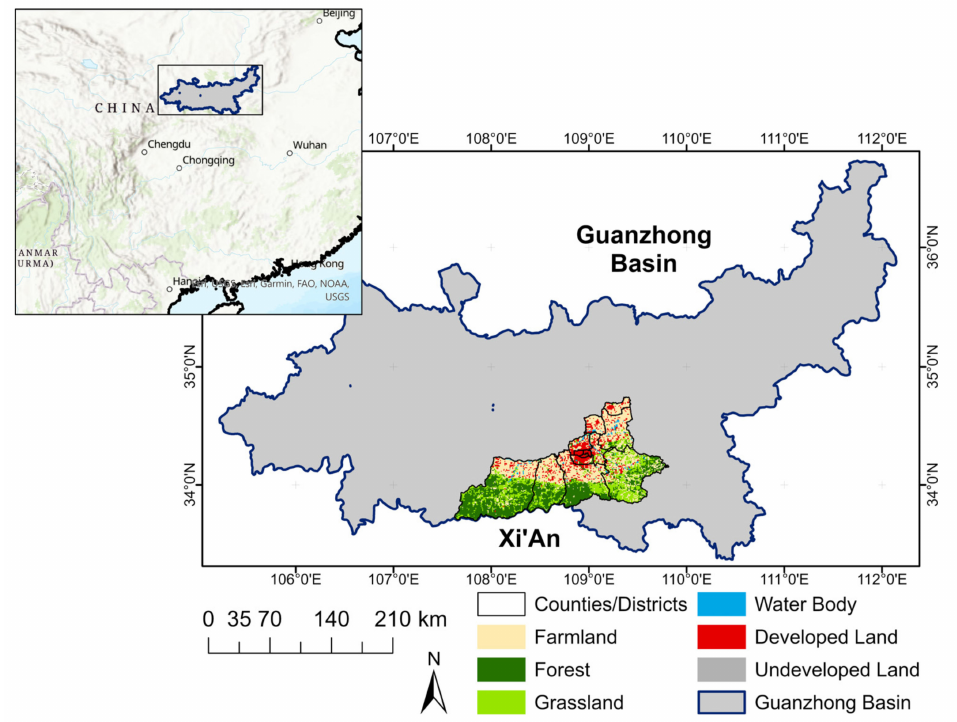
Figure 1. Land-use/cover and land-use change between the years 1995 and 2015 for Xi’an in